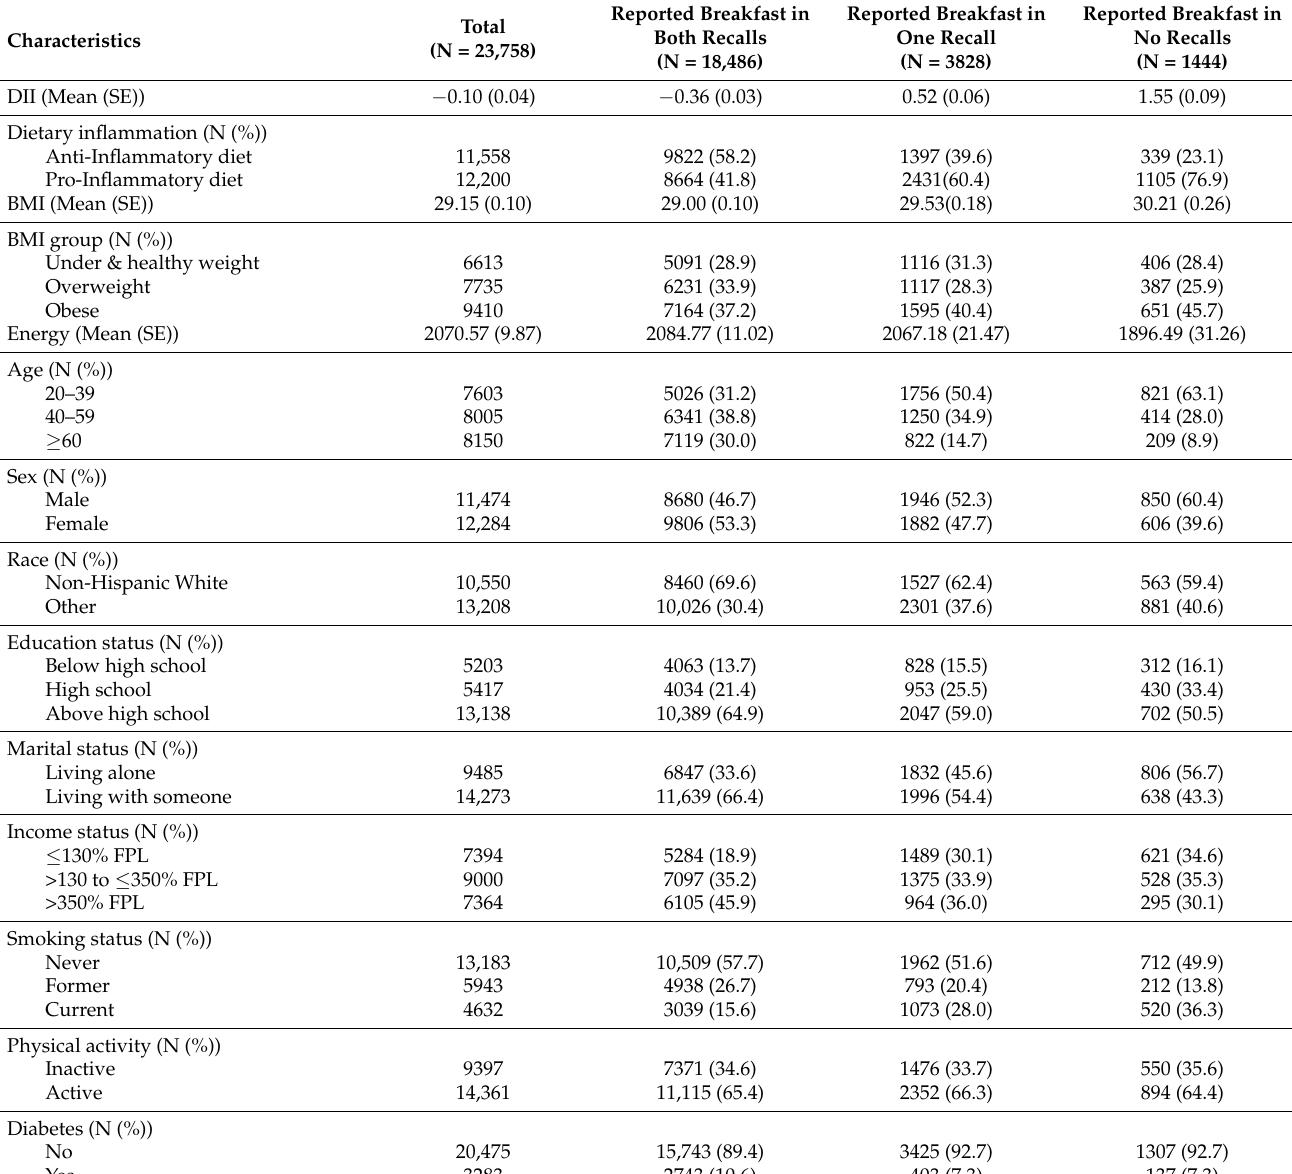
Table 1. Characteristics of participants reporting breakfast in both, one or no recalls (N